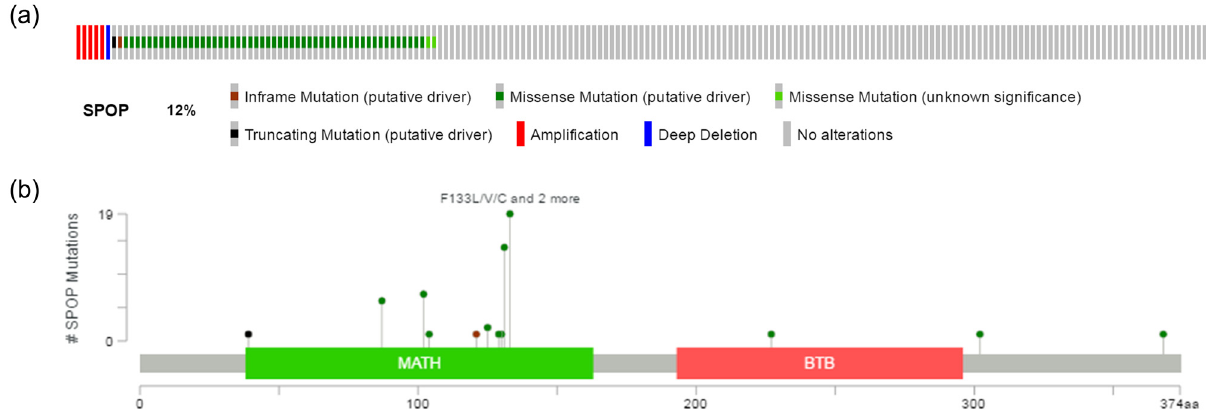
Figure 1: ( a ) Mutation frequency and ( b ) types of SPOP in PCa reproduced from TCGA